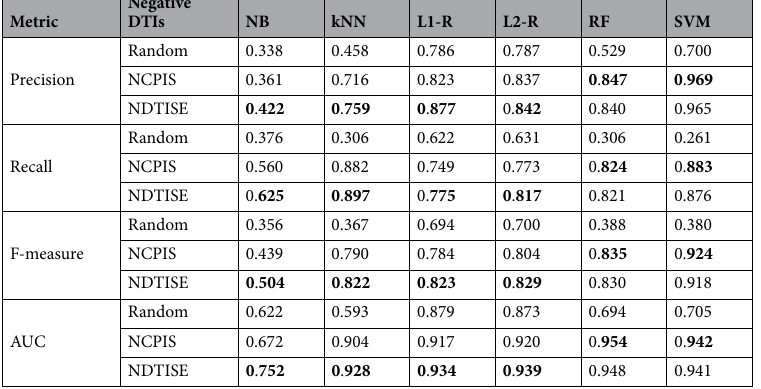
Table 1. Performance comparison of six classical classification models on random selection method, NCPIS and NDTISE.